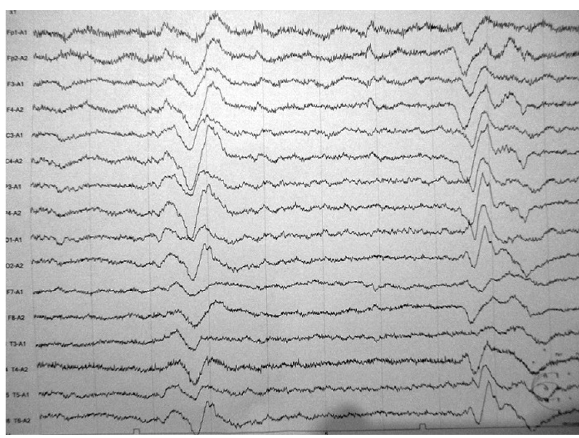
Figure 1. Electroencephalogram (EEG) showing generalized periodic activity at 5-6 Hz with asymmetrical background activity.